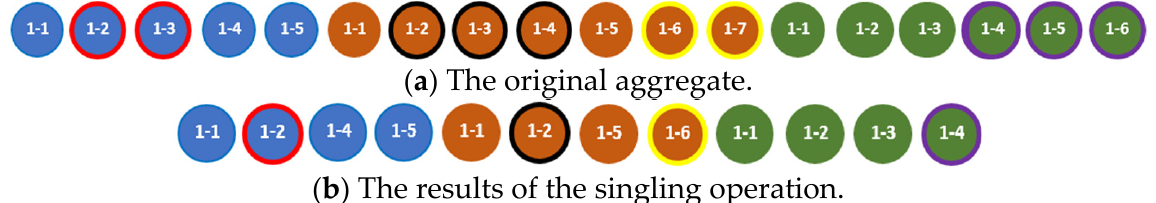
( a ) The original aggregate.